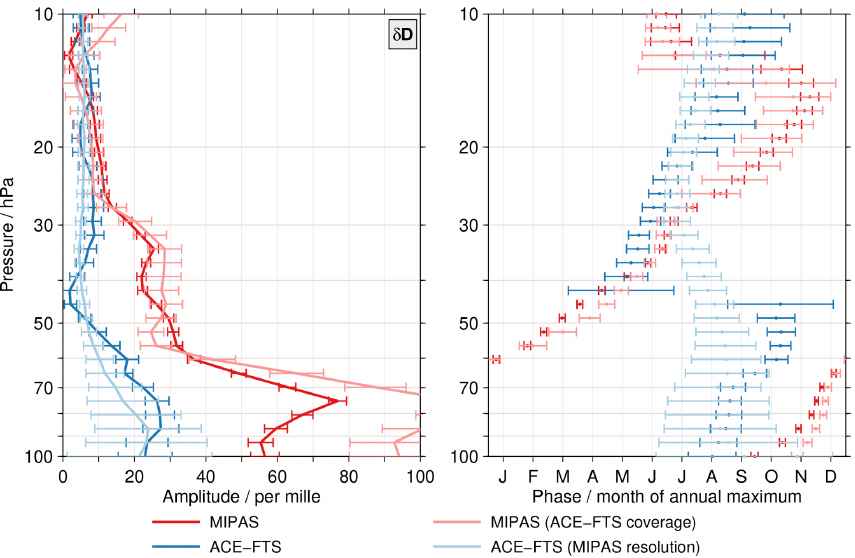
Figure 4. As for Fig. 3 but here focusing on test results for δ D. Results for a subsampled MIPAS data set that emulates the limited temporal coverage of the ACE-FTS observations in the tropics are shown in light red. The results given in light blue are based on ACE-FTS data whose vertical resolution had been degraded using a Gaussian window with a full width at half maximum of 6km. The original MIPAS (red) and ACE-FTS (blue) results are shown for comparison.